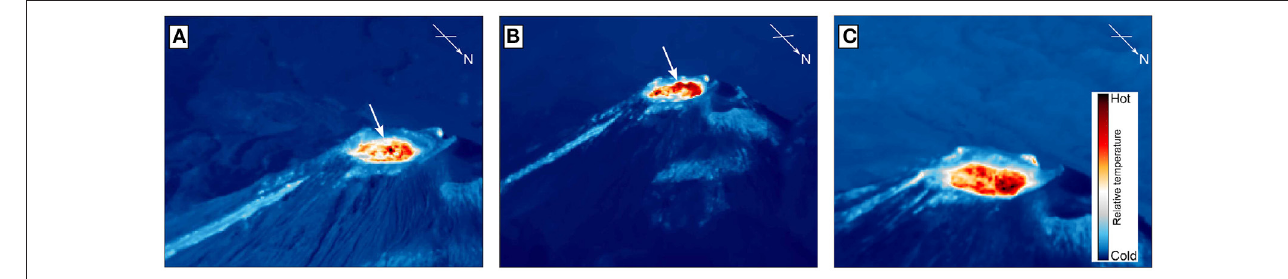
FIGURE 3 | Composite thermal images of the El Caliente dome and vent recorded from the vantage point on Santa Maria during (A) 29/11/2014, (B) 27/03–03/04/2015, and (C) 07–09/01/2016. The images were generated by stacking the frames of thermal videos taken during these time periods (63,424, 115,650, and 81,964 frames for each panel, respectively). Thus each panel represents an average of the relative dome temperature distributions during each period. For scale, the hot region within the vent is 200 m in diameter. The white arrows in (A,B) highlight the change from a concentrated hotspot to concentric fractures between the two dates.